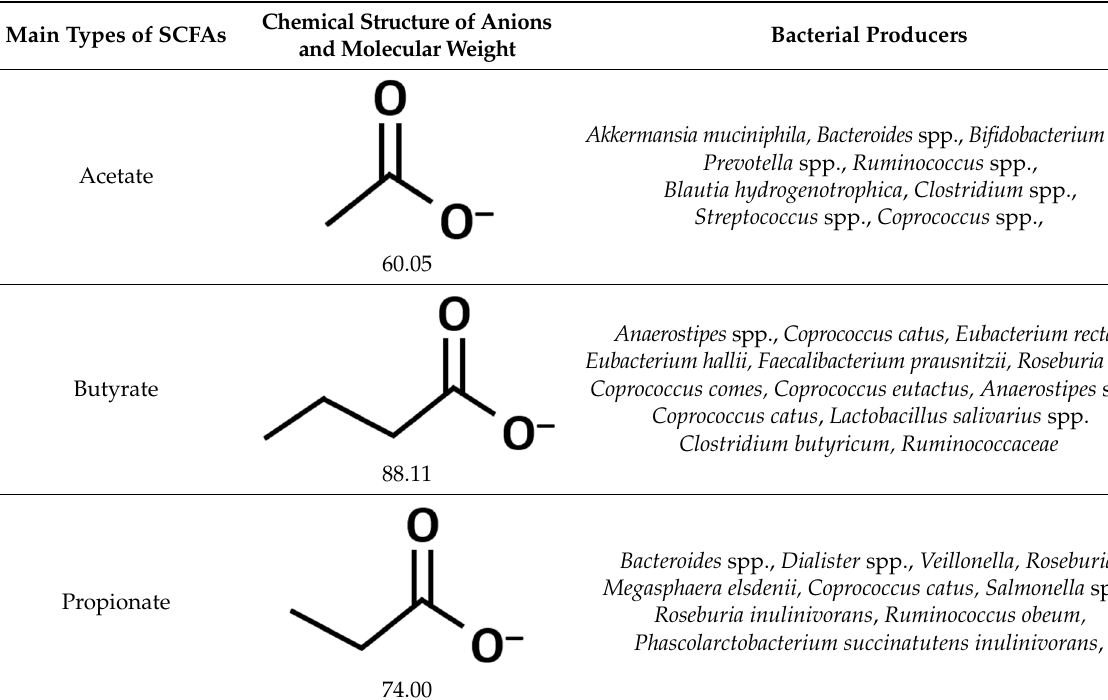
Table 1. Short-chain fatty acids and their bacterial producers.